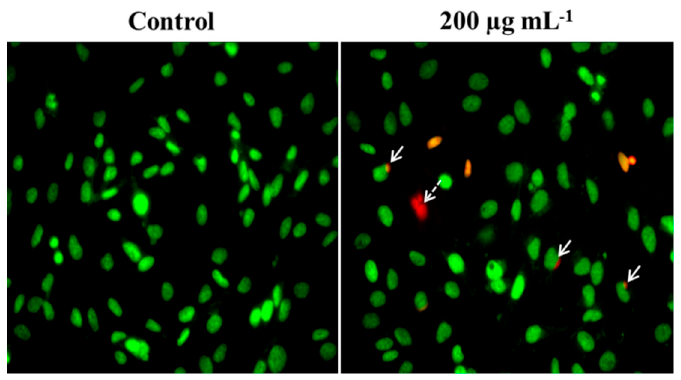
Figure 7. Annexin V-Cy3/6-CFDA staining of MBA-MD-231cells after 6 h of PDT treatment with or without phycocyanin, using a 625-nm laser at a power density of 80 mW·cm − 2 for 30